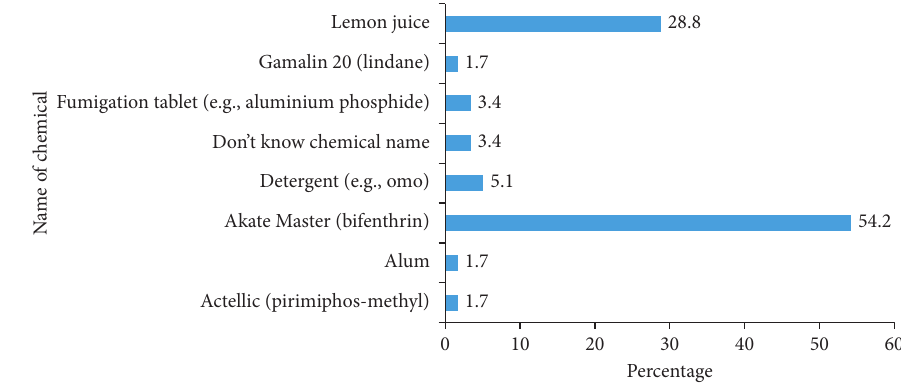
Figure 10: Chemicals used in solution for rinsing kola nuts.